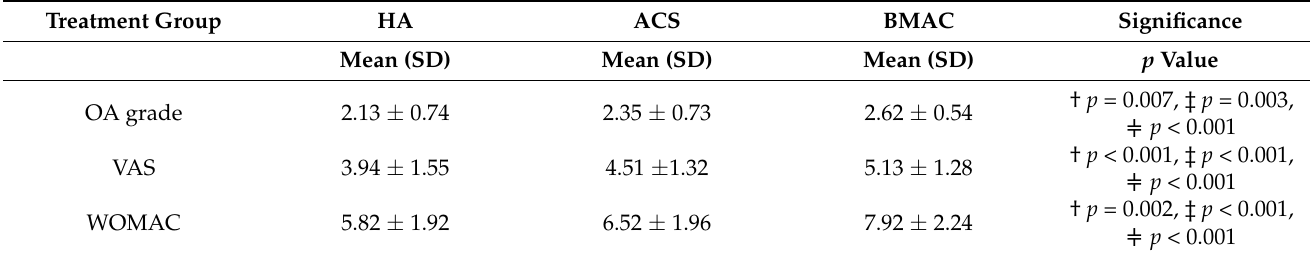
Table 2. Preintervention difference in grade of osteoarthritis, VAS and WOMAC scores between treatment groups.